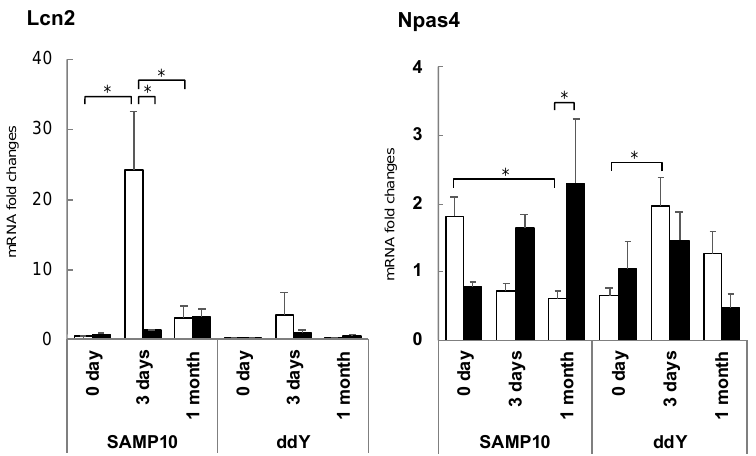
Figure 8. Expression levels of Lcn2 and Npas4 mRNA in the hippocampus of SAMP10 and ddY mice. Mice consumed theanine (closed bar) or normal tap water (control, open bar) ad libitum. After single housing for one month, hippocampal samples were obtained from mice housed confrontationally after 0 days, 3 days, and 1 month. Values are expressed as the means ± SEM (n = 3–6, * p < 0.05) [81].